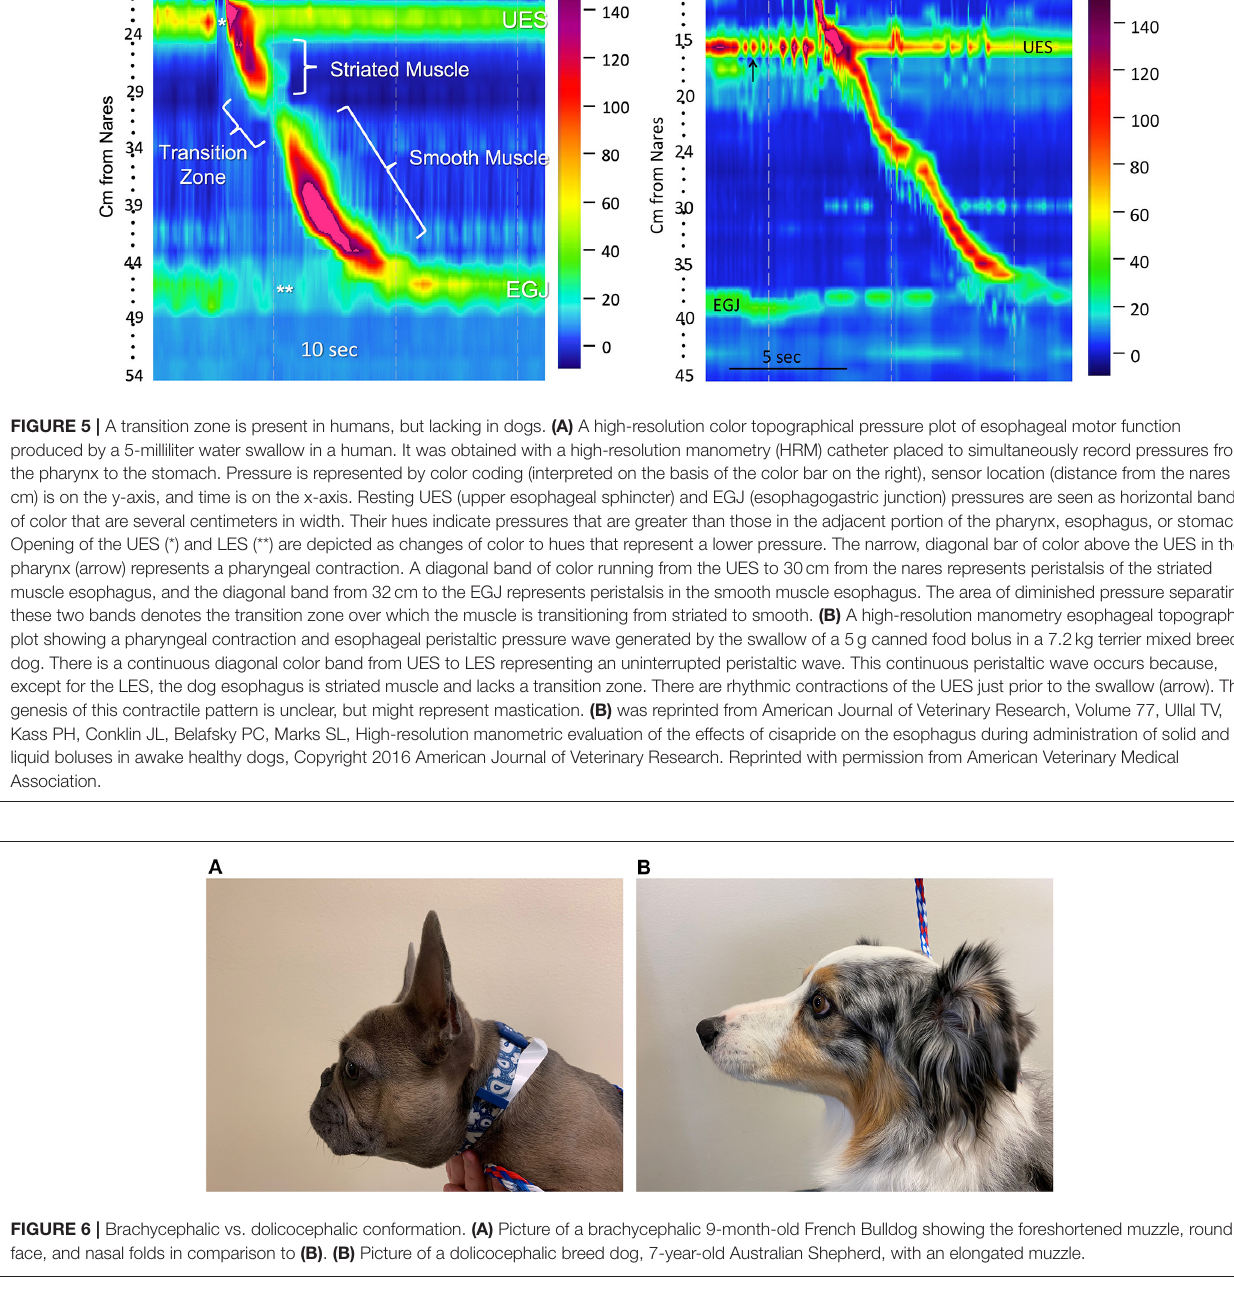
palpation, neurologic evaluation with cranial nerve tests and gag reflex, facial symmetry, muscle atrophy, body condition, and nutritional status. Finally, a critical aspect of the examination is observing the canine patient swallow, which can help characterize and localize the swallowing